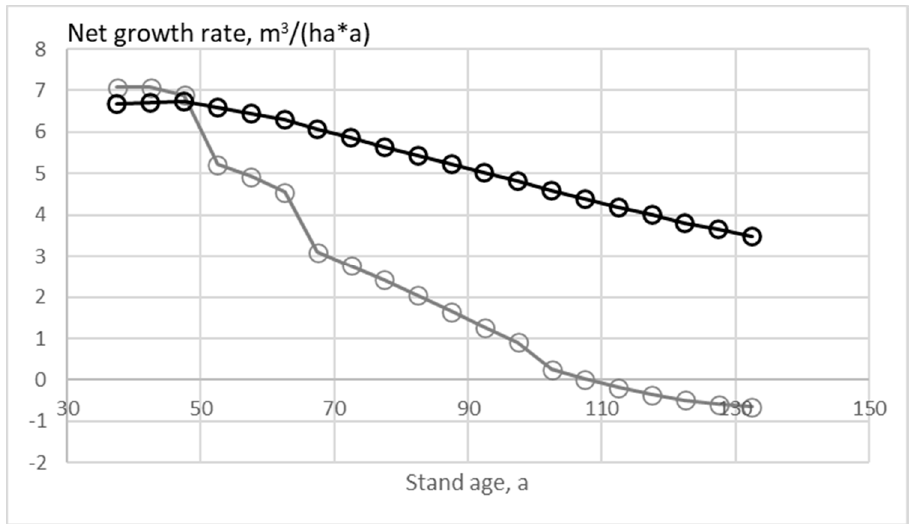
Figure 12. Net growth rate per year and hectare (thin drawing) and expected values accumulated over stand age (thick drawing), with thinnings from below.